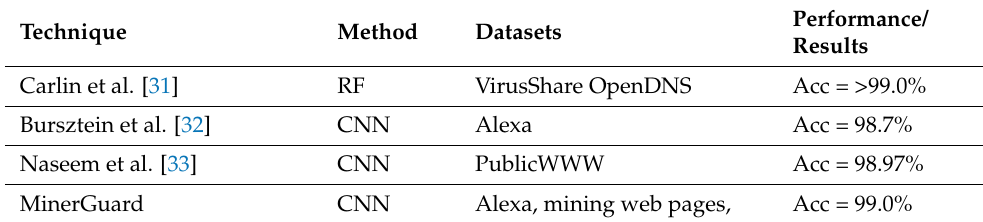
Table 1. Compared to the CPU use and methods.